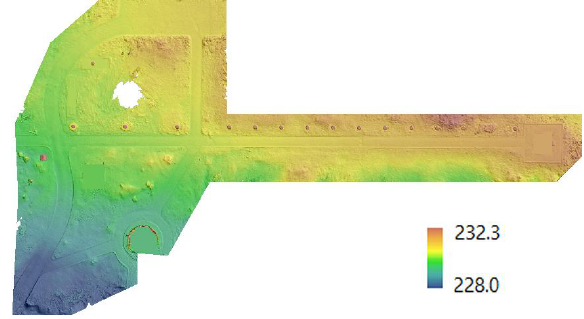
Figure 5. Colored DSM, with hill shading effect.